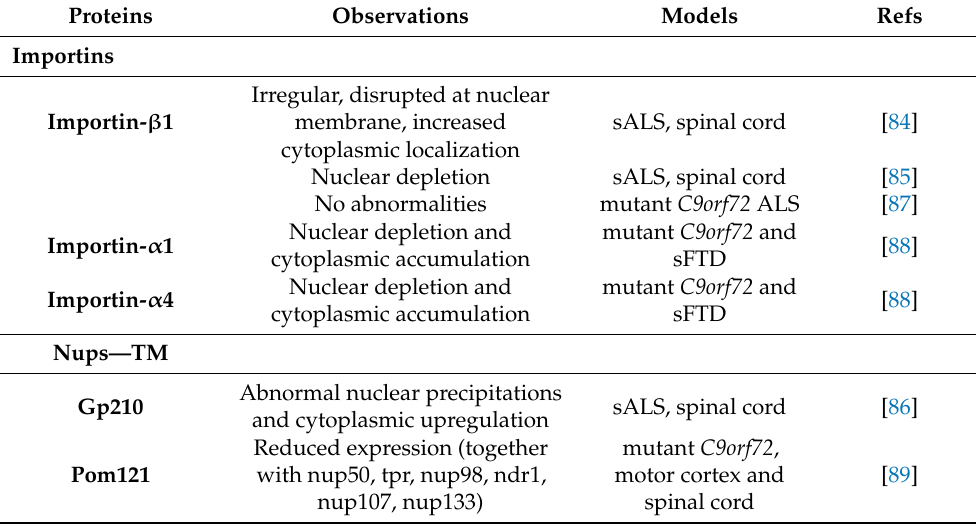
Table 1. Aberrant localization of proteins related to nucleocytoplasmic transport in postmortem tissue. Overview of the available evidence indicating whether or not proteins involved in nucleocytoplasmic transport were abnormally distributed in ALS and/or FTD patients. sALS: sporadic ALS; sFTD: sporadic frontotemporal